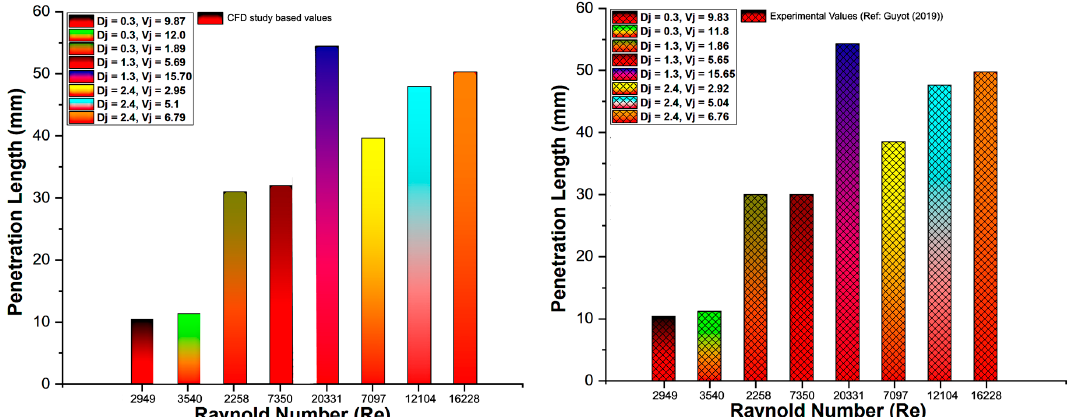
Figure 5. Penetration Length. ( a ) CFD Study-based Values; ( b ) Experimental Values.